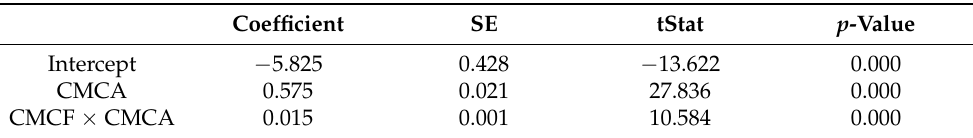
Table 2. Coefficients, standard error of the coefficients (SE), t-statistic for each coefficient (tStat) and p-value for the t-statistic of the hypothesis test whether the corresponding coefficient, obtained for MCP abduction/adduction estimation, is equal to zero or not ( p -value). CMCA: CMC abduc- tion/adduction; CMCF: CMC flexion/extension. Coefficient SE tStat p